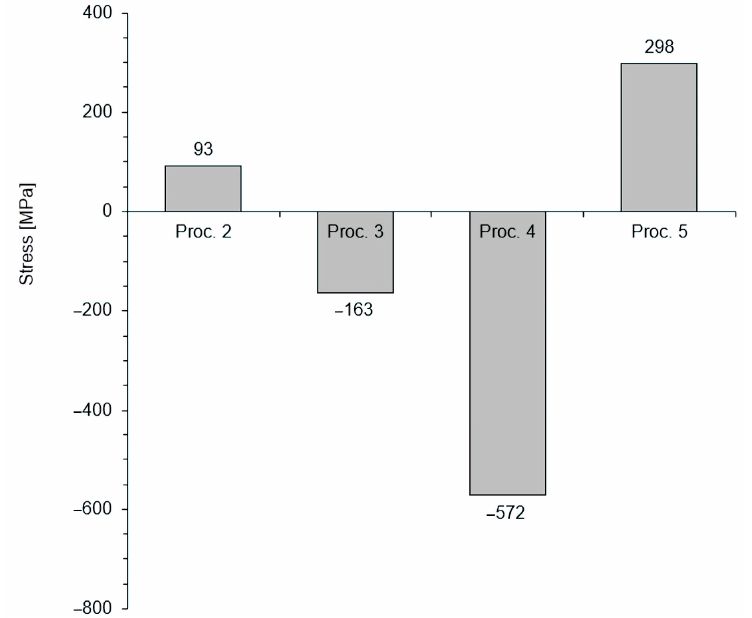
Figure 6. Residual stresses in the subsurface zone of the nitrided layer obtained in X37CrMoV5-1 steel after low-pressure nitriding.